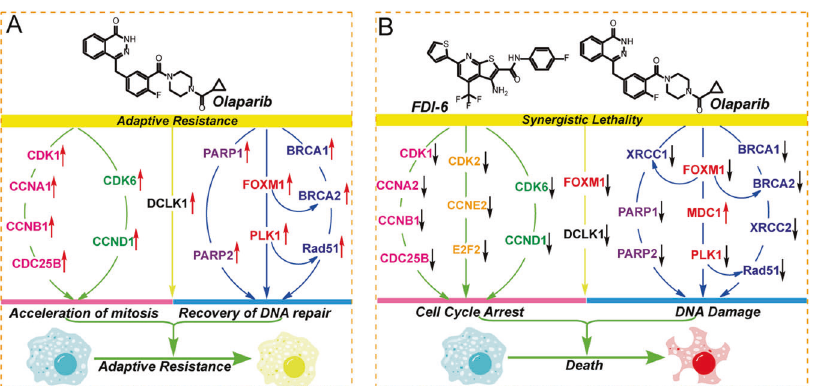
Fig. 7 Mechanism for the synergistic effects of FDI-6 and Olaparib on the treatment of TNBC cells in vitro and in vivo. A Long-term treatment of Olaparib induces adaptive response of TNBC cells by promoting cancer cell mitosis and DNA repair. B FOXM1 repression inhibits the expression of genes involved in cell cycle progression and DNA damage repair to sensitize TNBC cells to